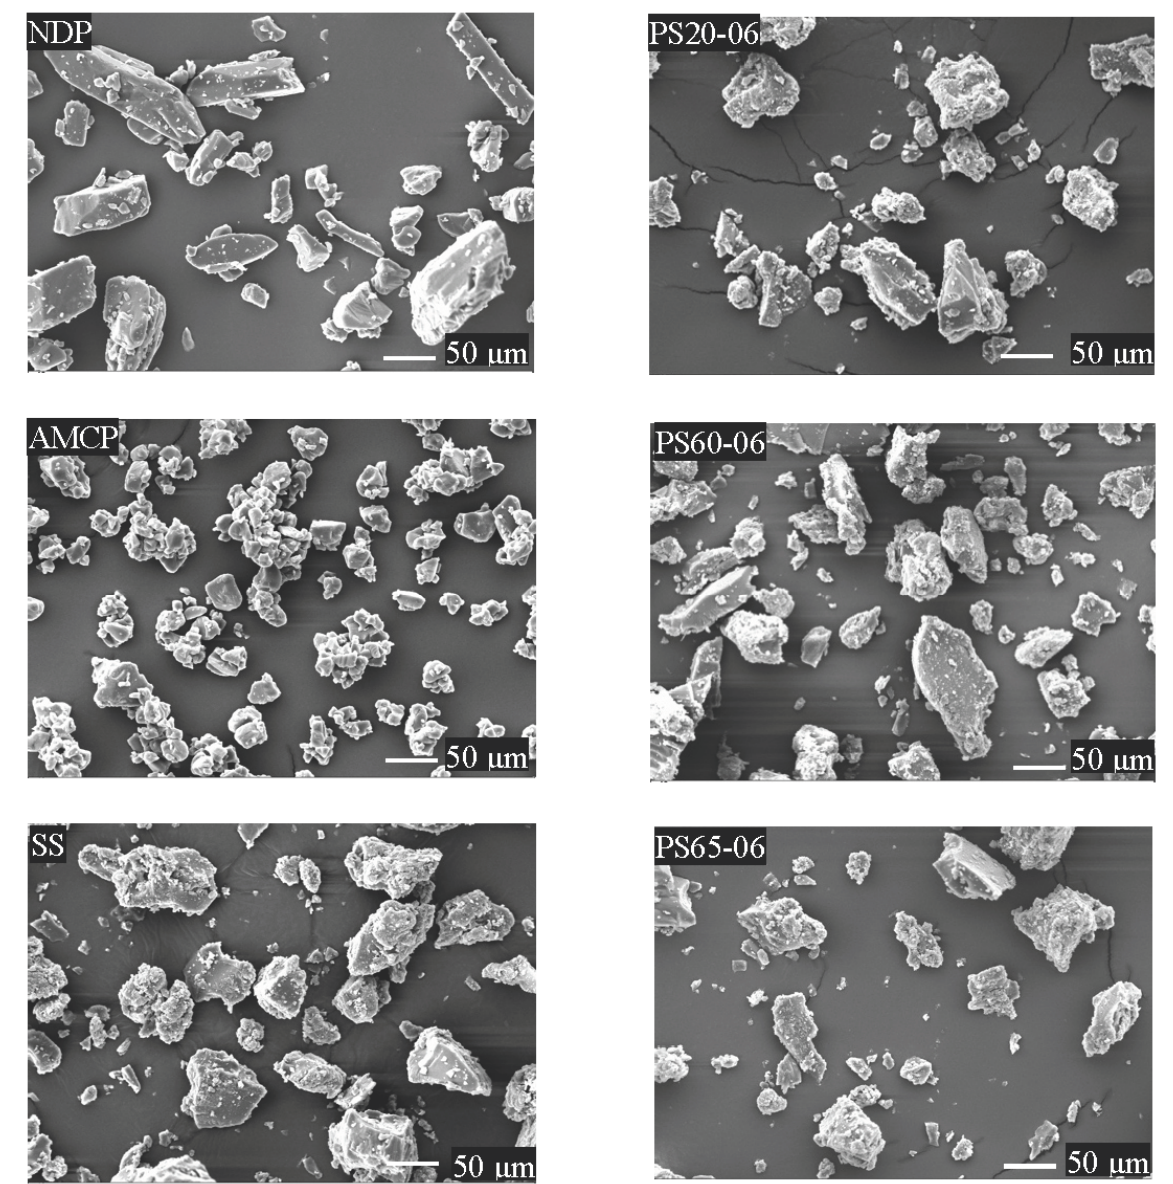
Figure 1. Scanning electron microscopy images (magnification, ×500) of nifedipine, amino methacrylate copolymer, and the solid solutions.